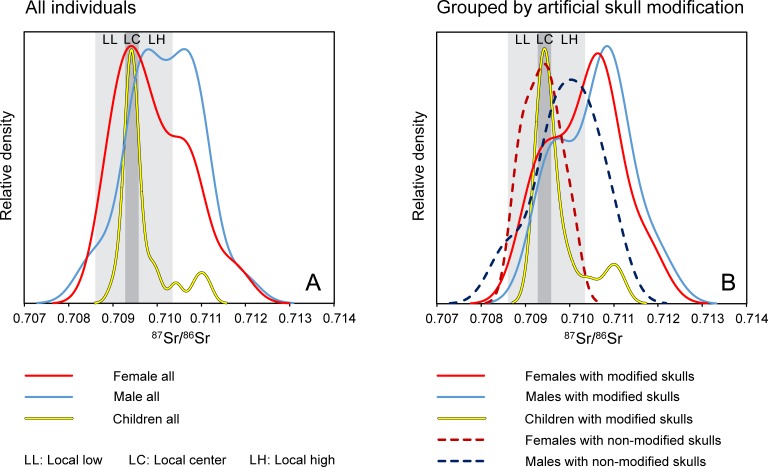
Kernel density curves of the 87Sr/86Sr ratio distribution.A) Differentiation according to sex and age; B) Differentiation according to sex and age as well as presence or absence of artificial skull modifications.